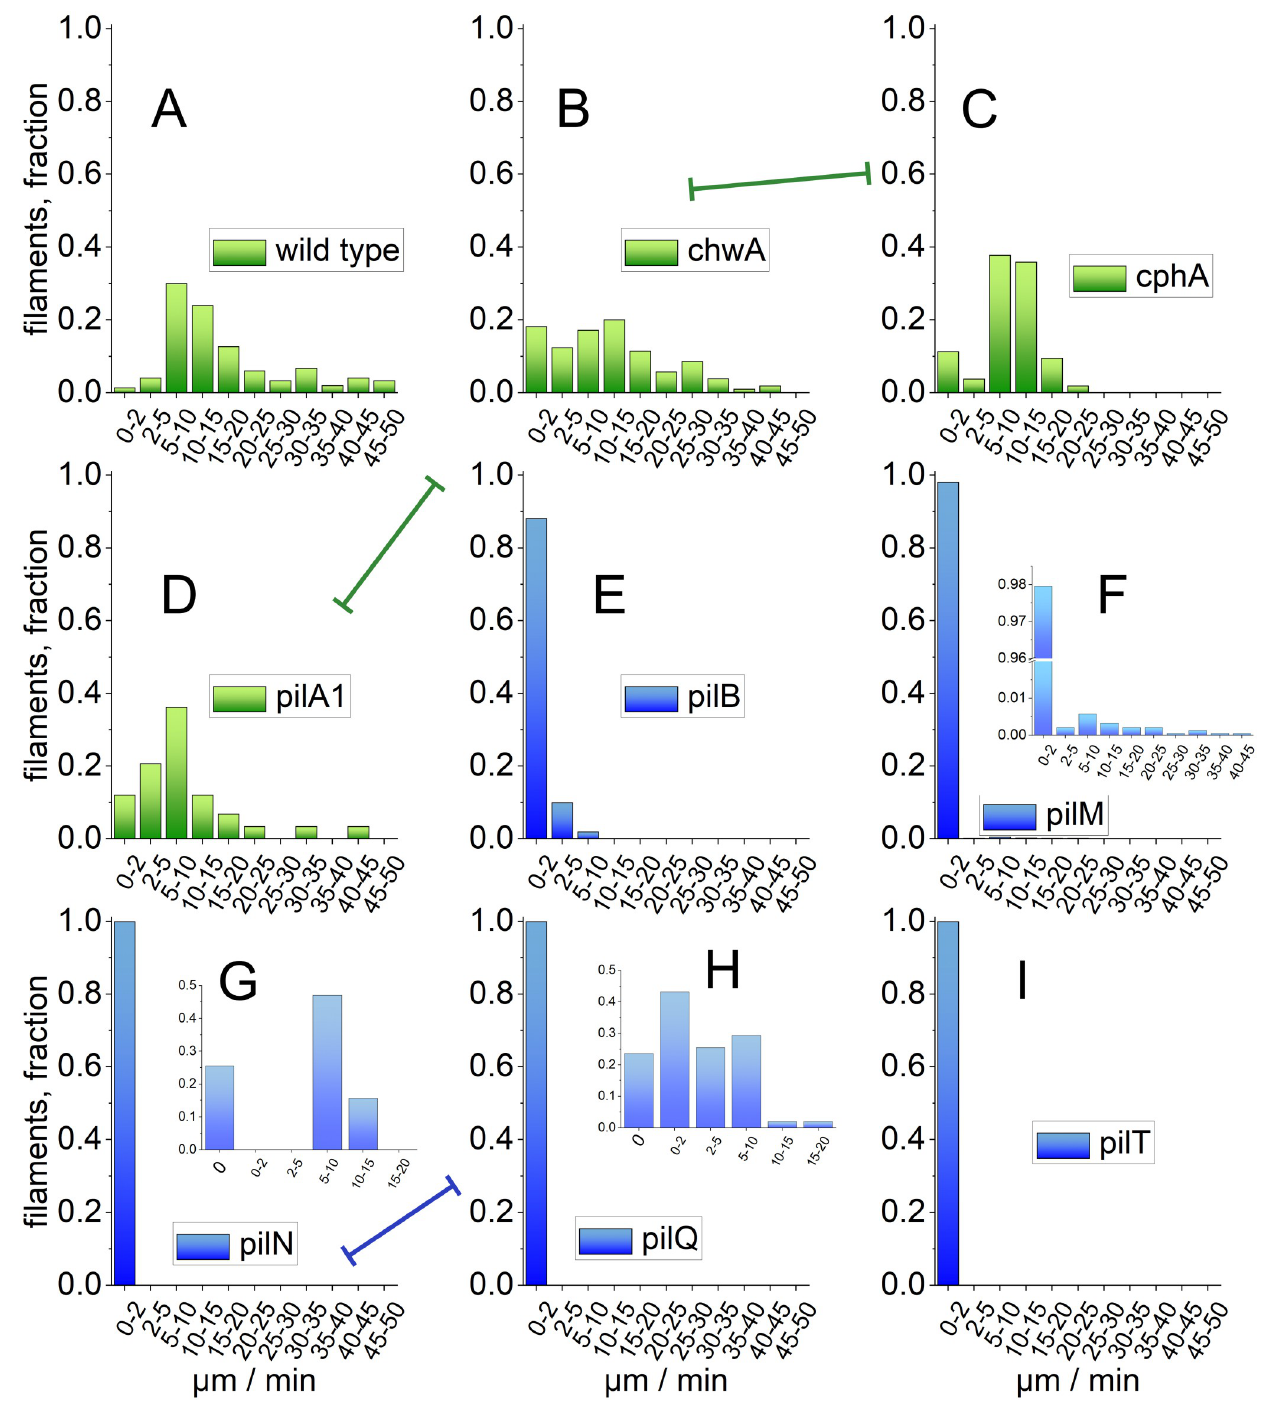
Fig 2. Histograms of motilities of wild type and mutant filaments after Utraturrax treatment on agar surface. Results of wild type (A), chwA (B), cphA (C) and pilA1’ are represented by green bars. These strains showed a clear motility on agar. Results of pilB (E), pilM (F), pilN (G), pilQ (H) and pilT (I) are represented by blue bars. In these strains motility is drastically restricted or zero. The inset in F shows the results of pilM with expanded Y-axis. The insets in G and H for pilN and pilQ are based on 1 h measurements that were calculated back to 1 min for comparison. The 1 h measurement of pilT did not indicate any movement and is not shown. The lines with blocked ends are drawn between pairs of mutants that have no significantly different data (B–D, C–D, G– H), those of all other pairs of mutants or wild type are significantly different (Kruskal Wallis test, p < 0.05).